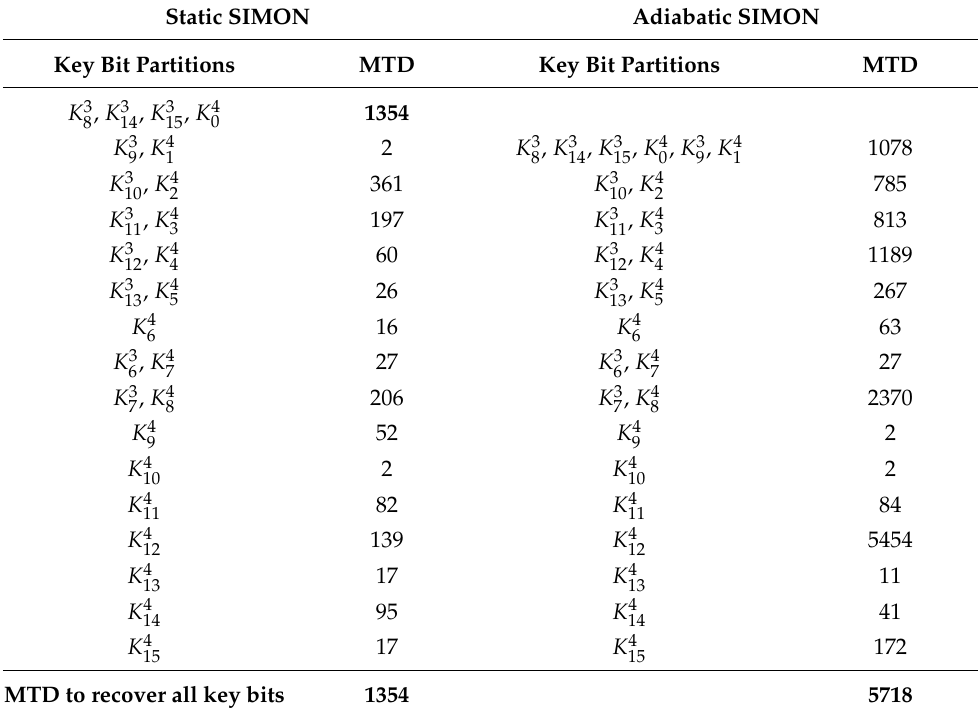
Static SIMON Adiabatic